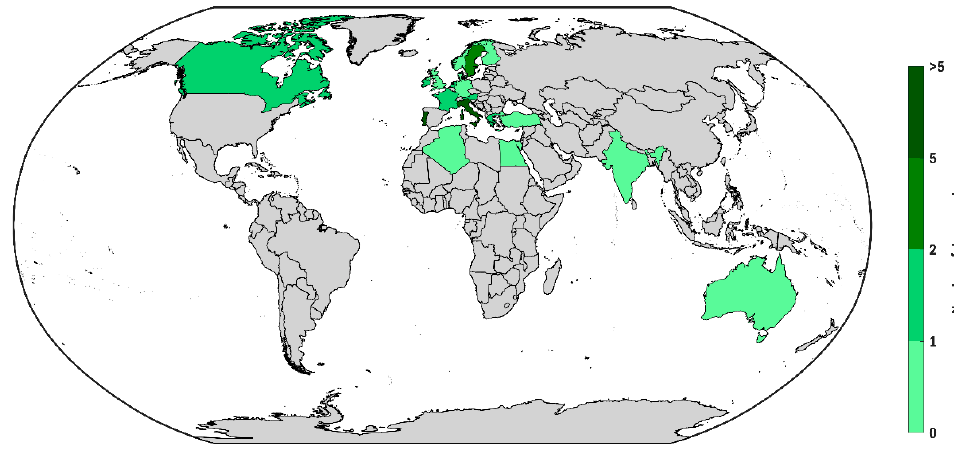
Figure 5. World map of the distribution of publications on the covered research field. Table 2. Top institutions with (minimum two) documents published on the covered research sub- ject.